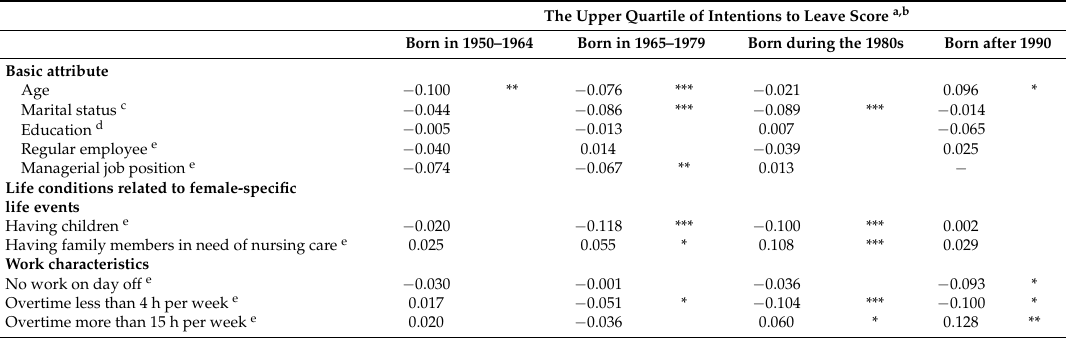
Table 3. Spearman’s correlation coefficients between the dependent variable and each